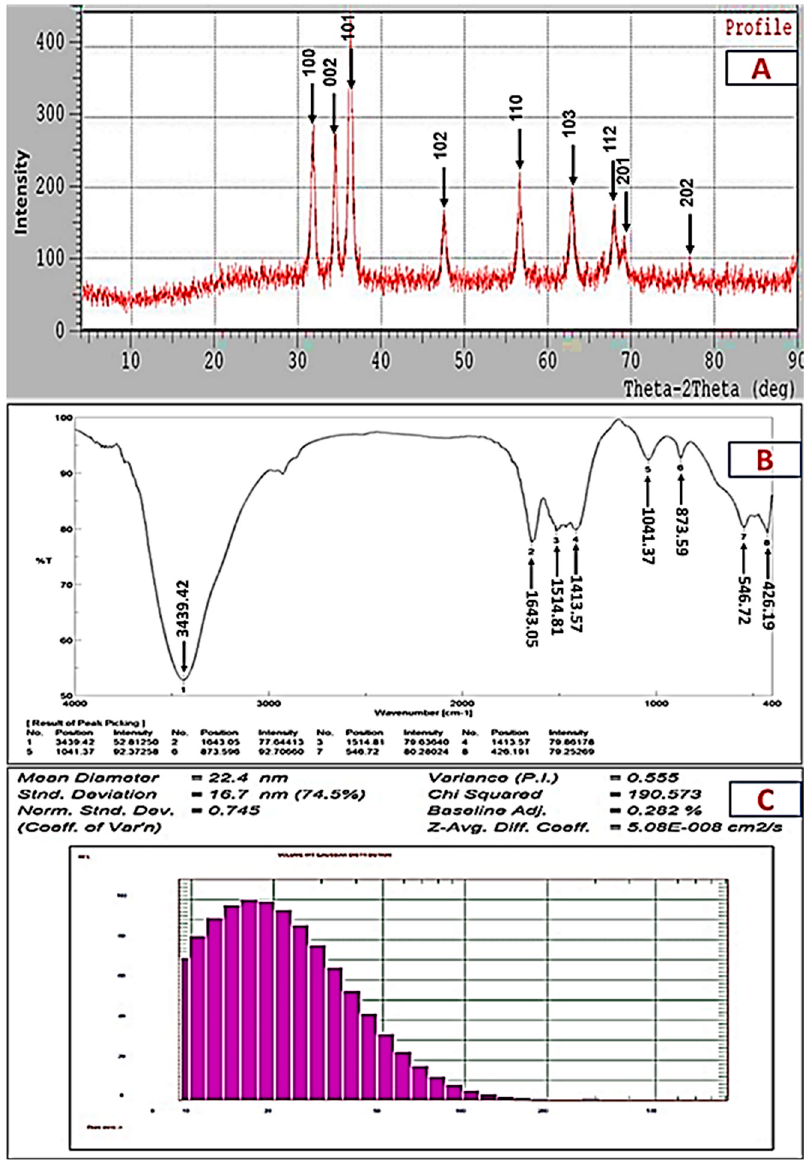
Figure 3. XRD pattern ( A ), FTIR spectrum ( B ) and particle size distribution ( C ) of ZnO ‐ NPs formed from isolate MK ‐ 104.